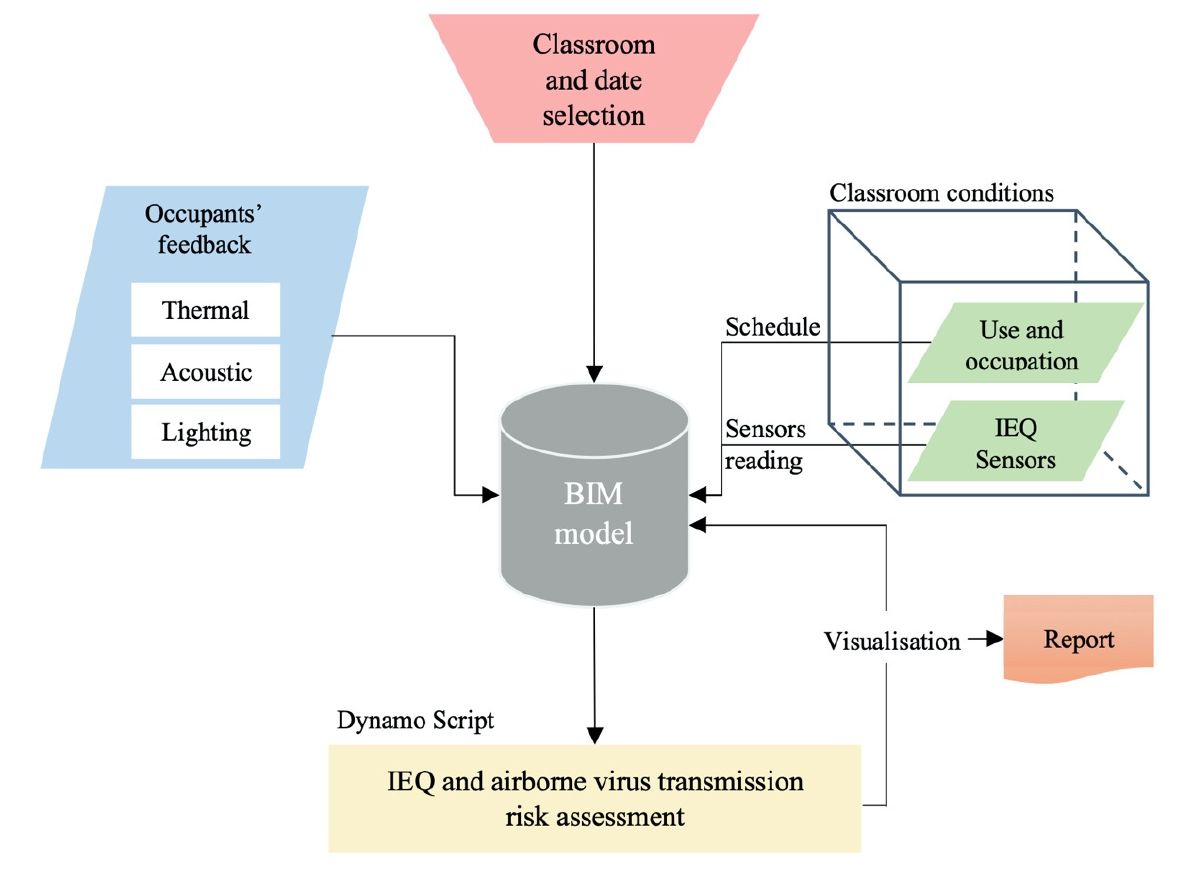
Figure 2. Workflow of the system developed in BIM.